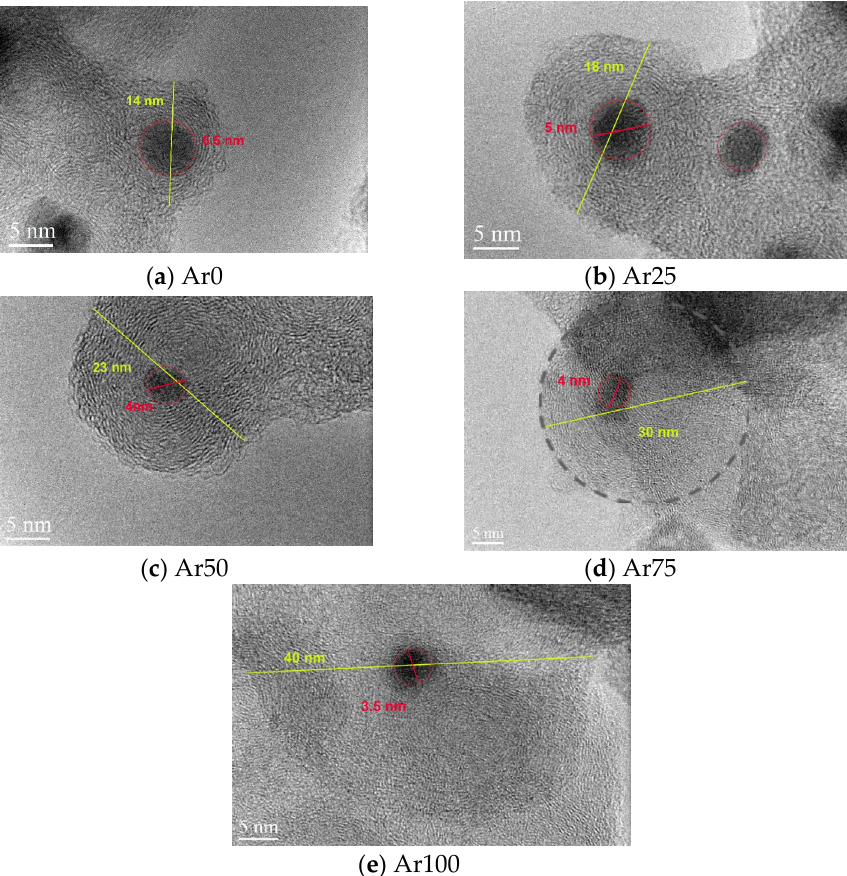
Figure 4. The size variations of CEINPs components are evident in HRTEM images. The 100% helium is used to synthesize Ar0 sample, by adding and increasing 25% argon, the carbon shell formed larger and iron core formed smaller, as can be observed in Ar25 image, the same trend is shown in Ar50, Ar75, and Ar100 images, respectively. ( a ) Ar0; ( b ) Ar25; ( c ) Ar50; ( d ) Ar75; ( e ) Ar100.